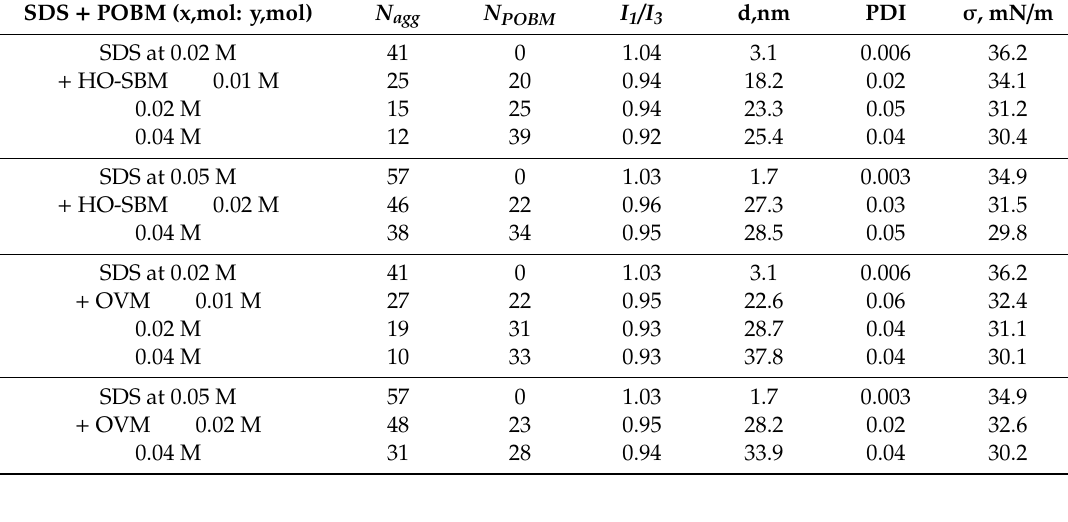
Figure 12. Possible location of the polar “heads” in a direct micelle from the SDS molecules and the POBM/SDS aggregate.